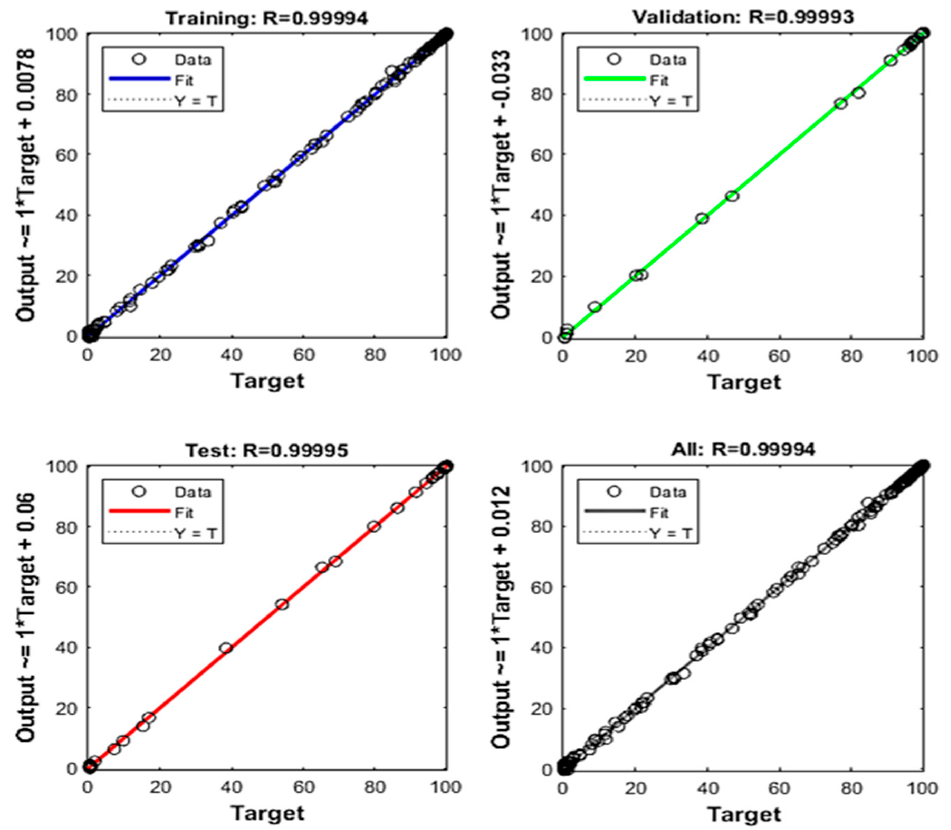
Figure 2. Regression of training, validation, and test plots.